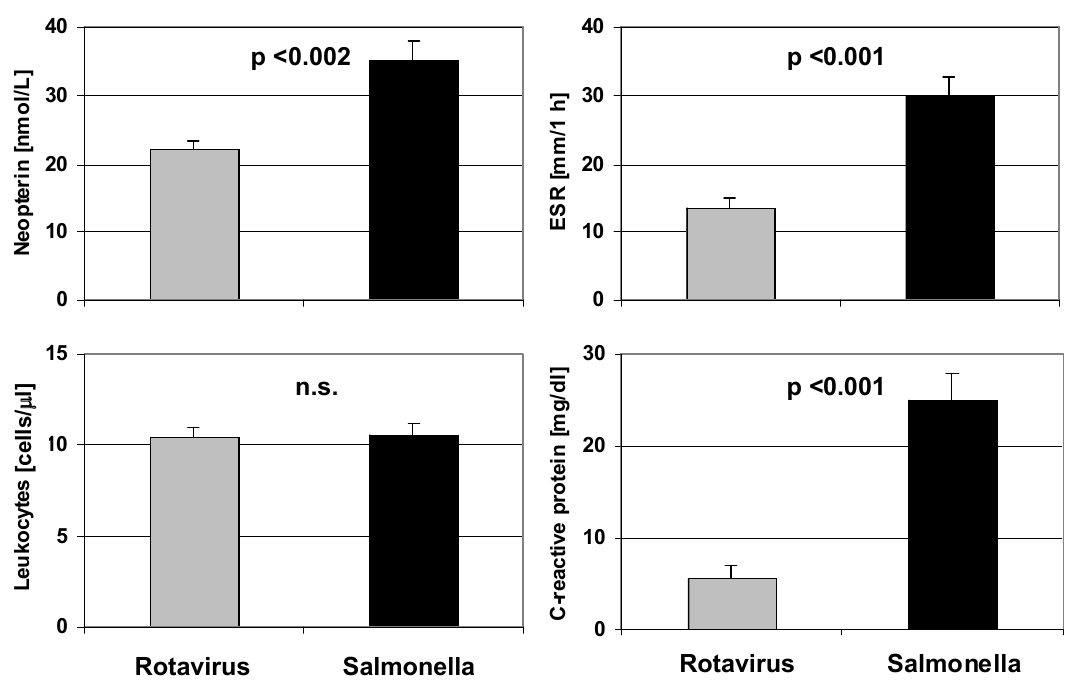
Figure 1. A comparison of different inflammation markers in children with acute diarrhea caused by rotavirus (left columns) or salmonella (right columns). Mean values and S.E.M. are shown, for p-values Mann Whitney U- test was Table 1. A comparison of inflammation markers in children with acute diarrhea caused by rotavirus (Group R) or salmonella (Group S)